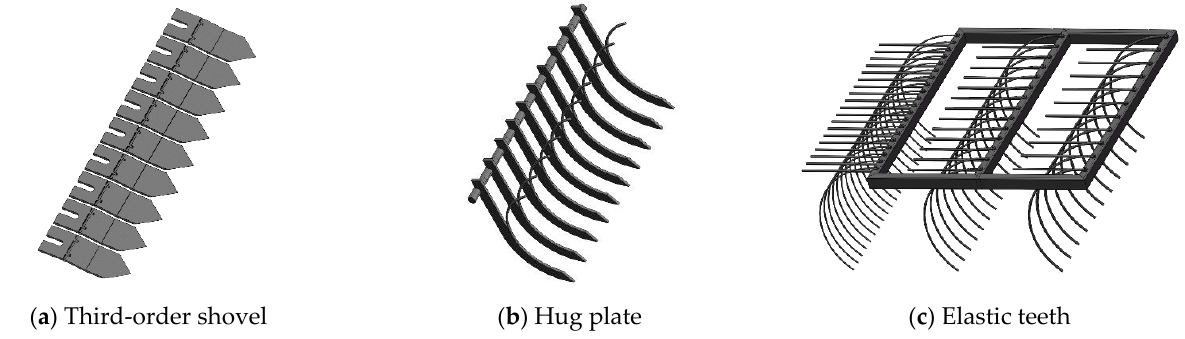
Figure 3. Three-dimensional model of typical film-lifting parts.